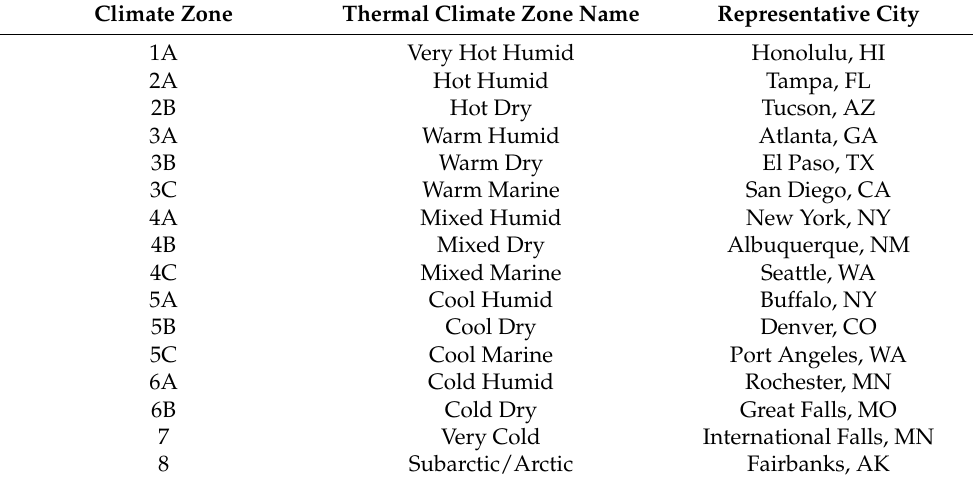
Figure 2. The basic situation of the DOE medium office building model: ( a ) 3D model; ( b ) thermal zones; ( c ) occupant behavior schedules. Table 1. The characteristics of the sixteen cities and climate zones in the U.S.